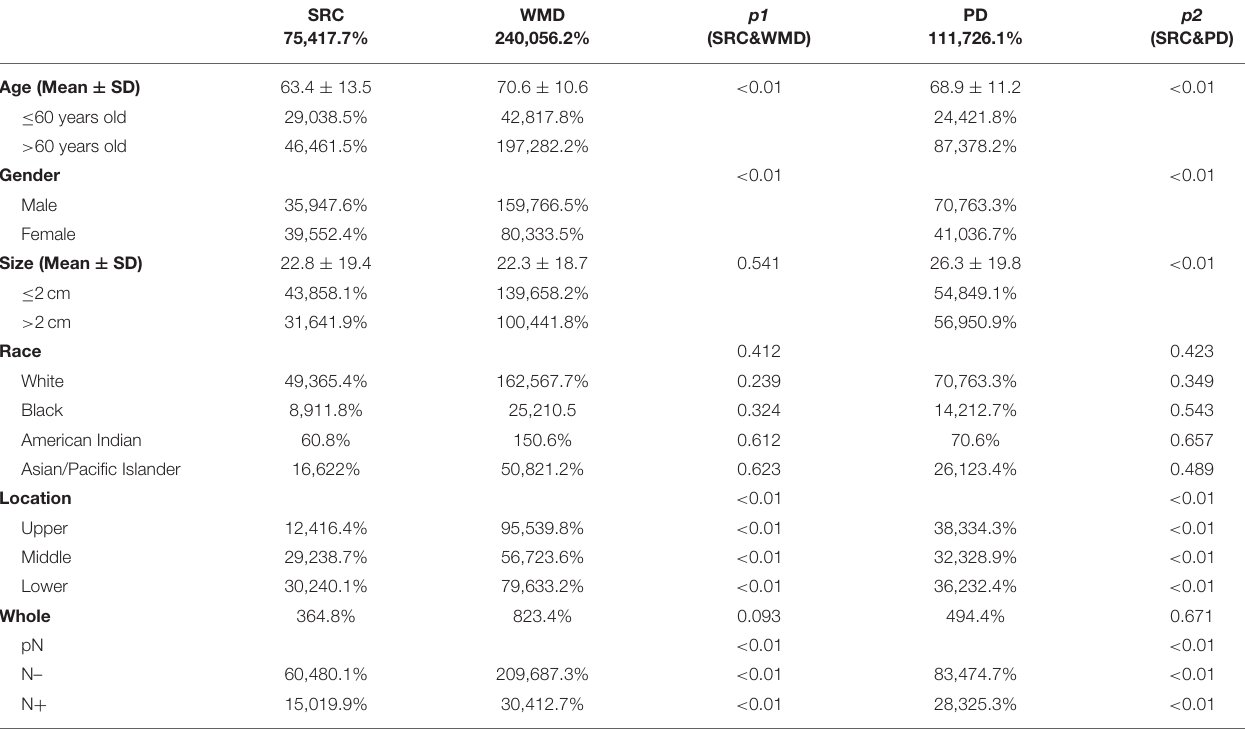
TABLE 1 | Comparison of clinicopathological characteristics in early gastric